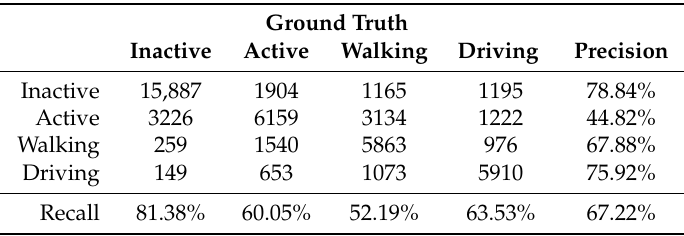
Table 9. Average confusion matrix for the experiments conducted.